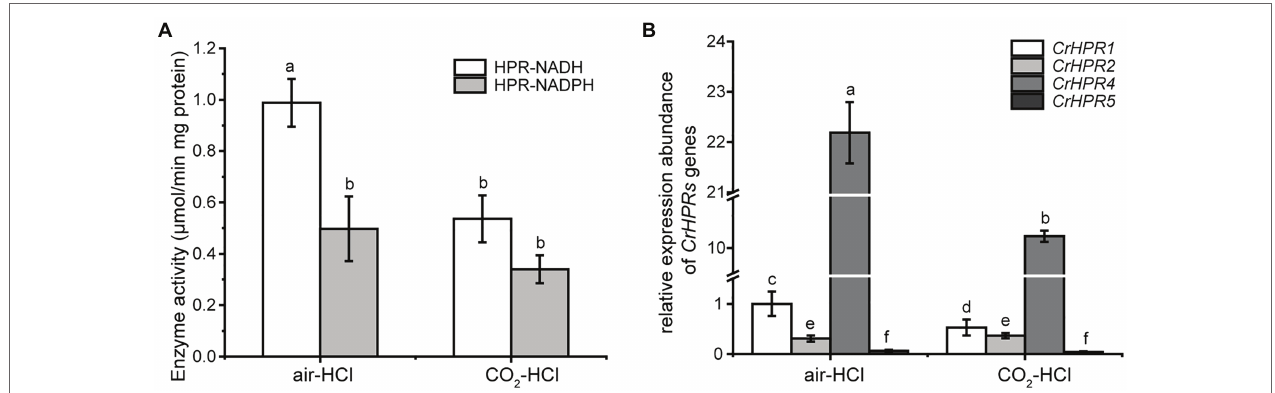
FIGURE 2 | Enzyme activity assay and measurement of CrHPRs transcripts in photorespiration (air) and non-photorespiration conditions (CO 2 ). (A) Assay of CrHPRs enzyme activity. (B) Detection of CrHPRs in transcriptional level. Mean values ± SD are from three independent measurements. Means denoted by the same letter did not significantly differ at p <